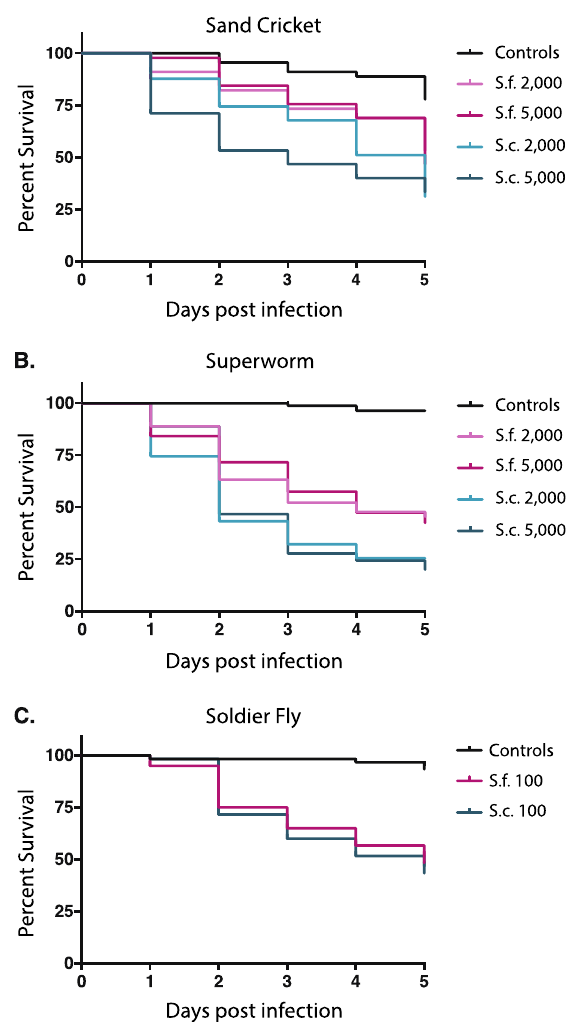
Figure 3. Survival of host insects after exposure to different doses of S. carpocapsae or S. feltiae IJs. ( A ) Sand cricket adults exposed to nematode IJs; ( B ) Superworm larvae exposed to nematode IJs; ( C ) Soldier fly larvae exposed to nematode IJs. Hosts exposed to water but no IJs served as controls. Survival was monitored every 24 h up to 120 h post-exposure. Values represent the total of three experiments performed for each host and dose. Data was analyzed using log-rank analysis in GraphPad Prism software.